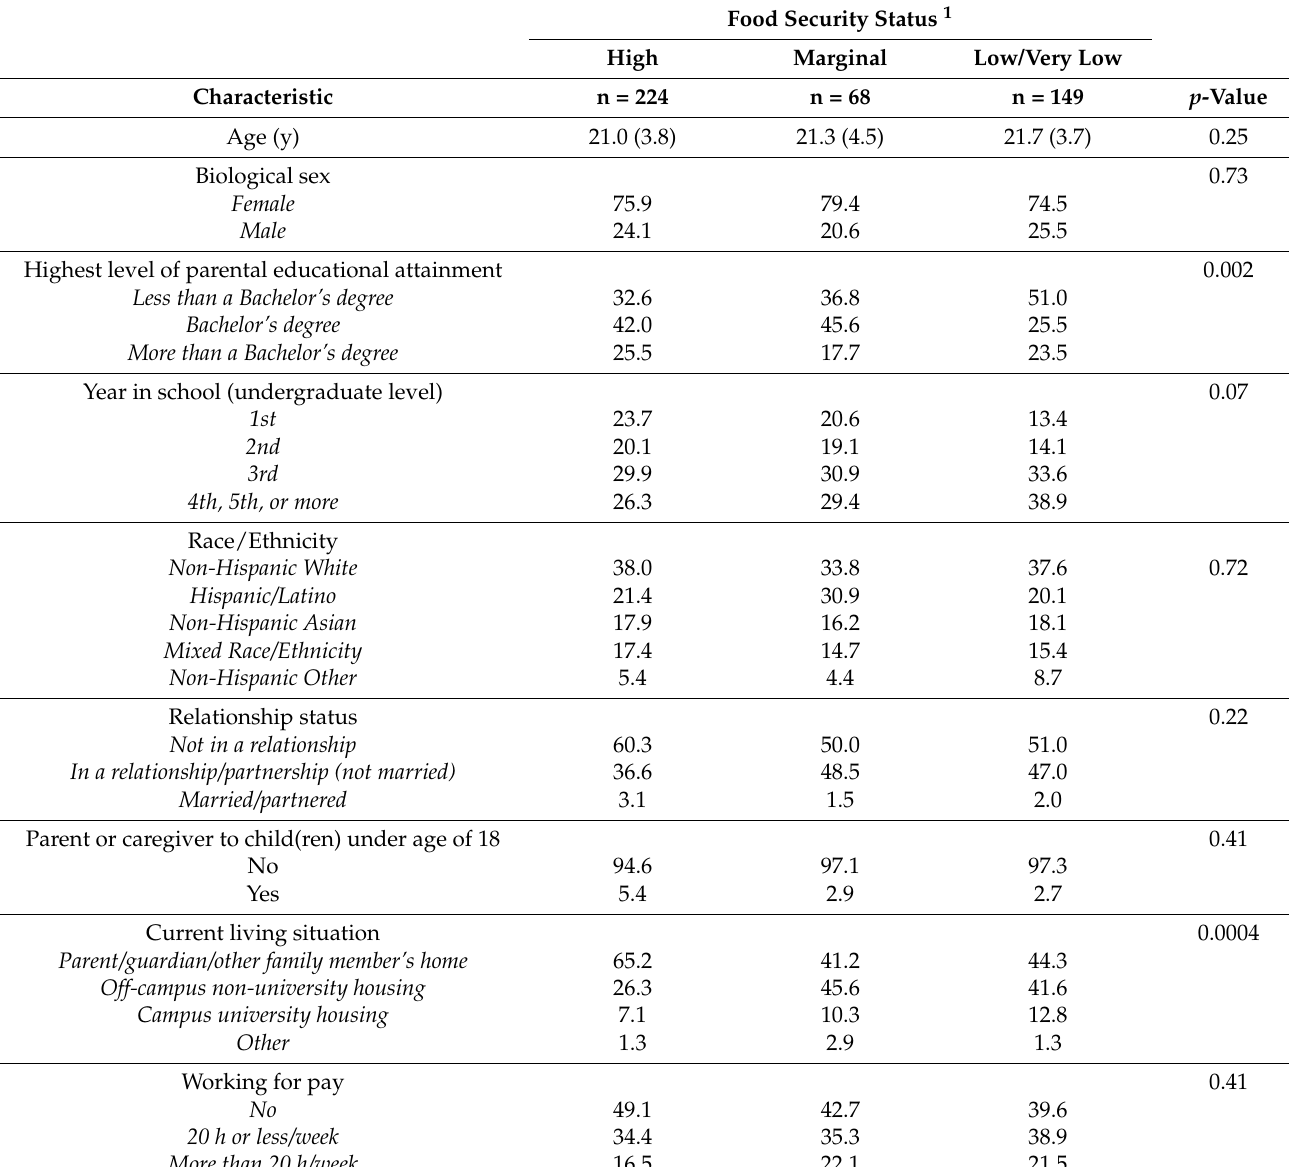
Table 1. The characteristics of full-time undergraduate students by food security status (n =